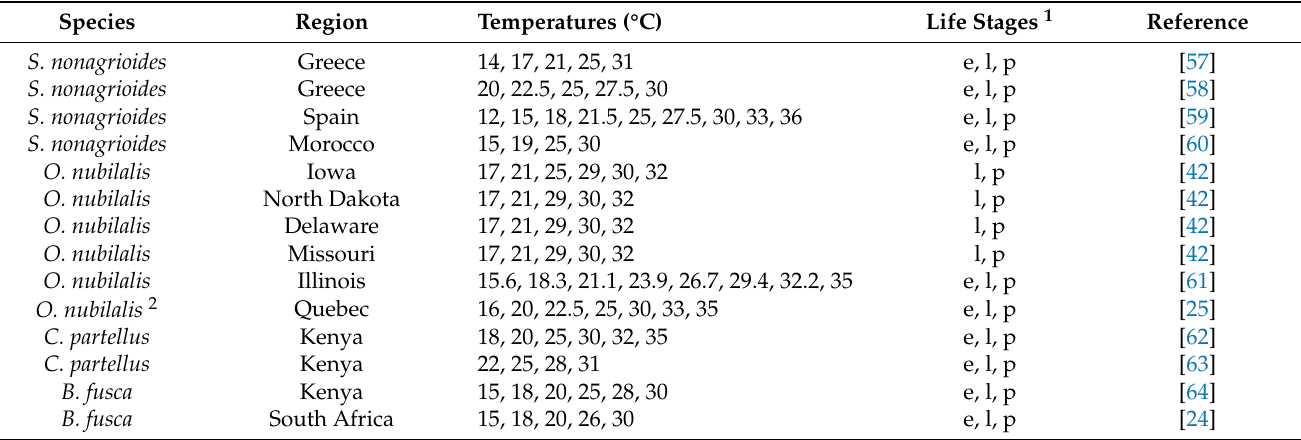
Table 1. Studies from which the data were extracted to build thermal performance curves of develop- ment rate.